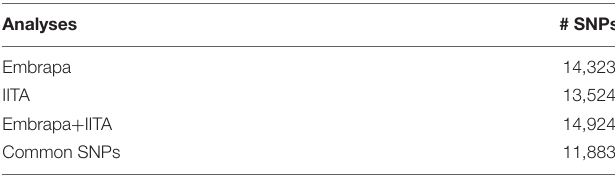
TABLE 2 | Number of single nucleotide polymorphisms (SNP) in each data file after quality control, and the number of shared SNPs between data files after quality control / 1